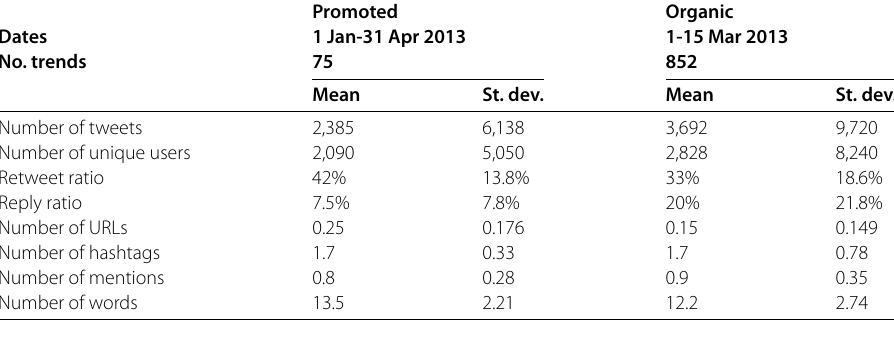
Table 1 Summary statistics of collected data about promoted and organic trends on Twitter Promoted Organic Dates 1 Jan-31 Apr 2013